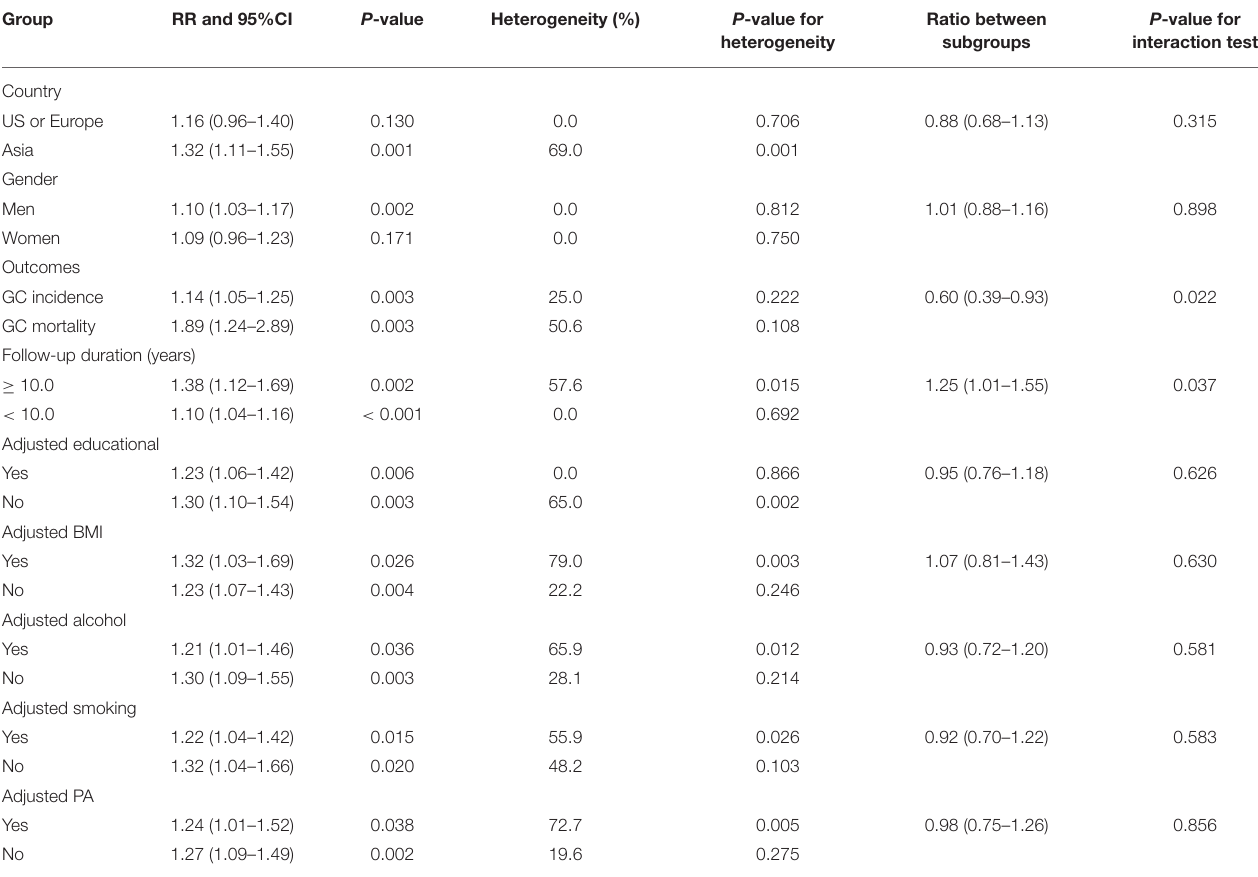
TABLE 2 | Subgroup analysis for high vs. low salt intake and the risk of gastric cancer. Group RR and 95%CI P -value Heterogeneity (%) P -value for